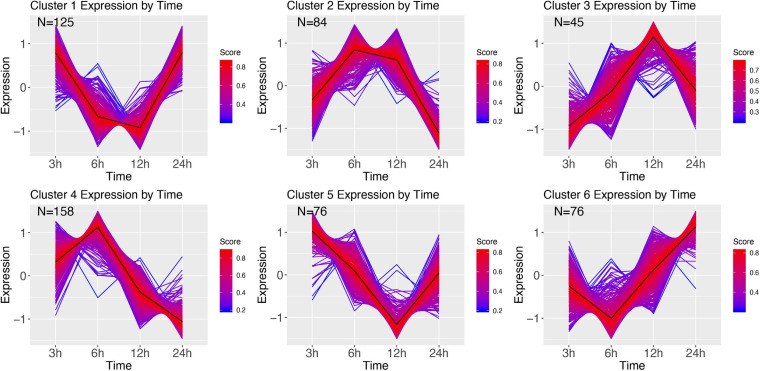
DEG clusters during E. coli infection over 24 h. Color indicates cluster membership score, ranging from 0 (blue) to 1 (red). Numbers in each graph represent the number of genes in this cluster with a membership score above 0.6.